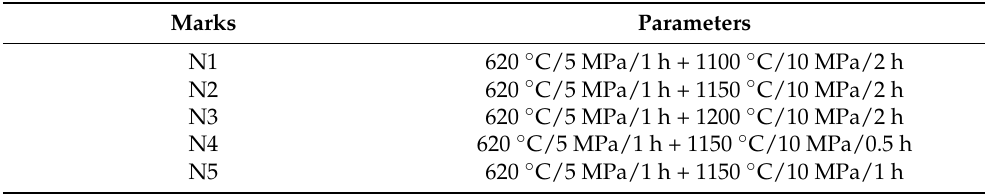
Table 1. The hot pressing processing parameters for the laminated Ni/Al foils and their correspond- ing